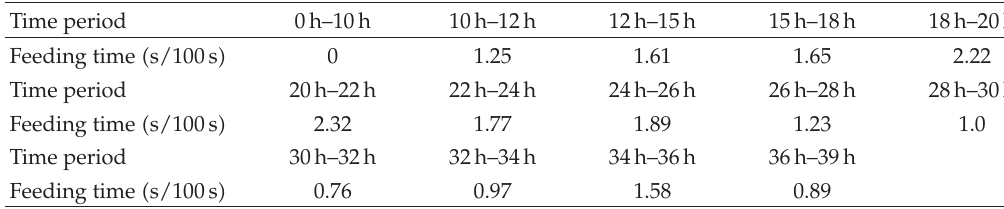
Table 1: Glycerol feeding strategy.